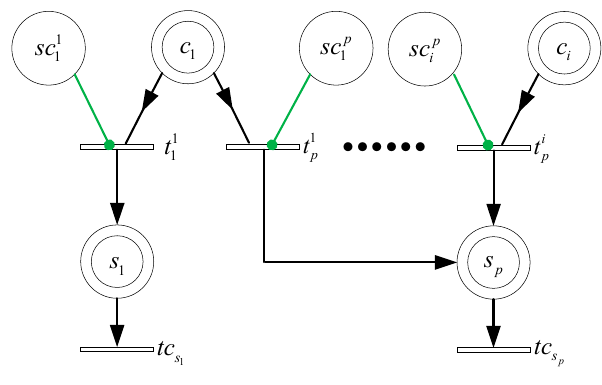
Figure 5. Fixed charging subnet. Table 2. Interpretation of place and transition for fixed charging subnet.